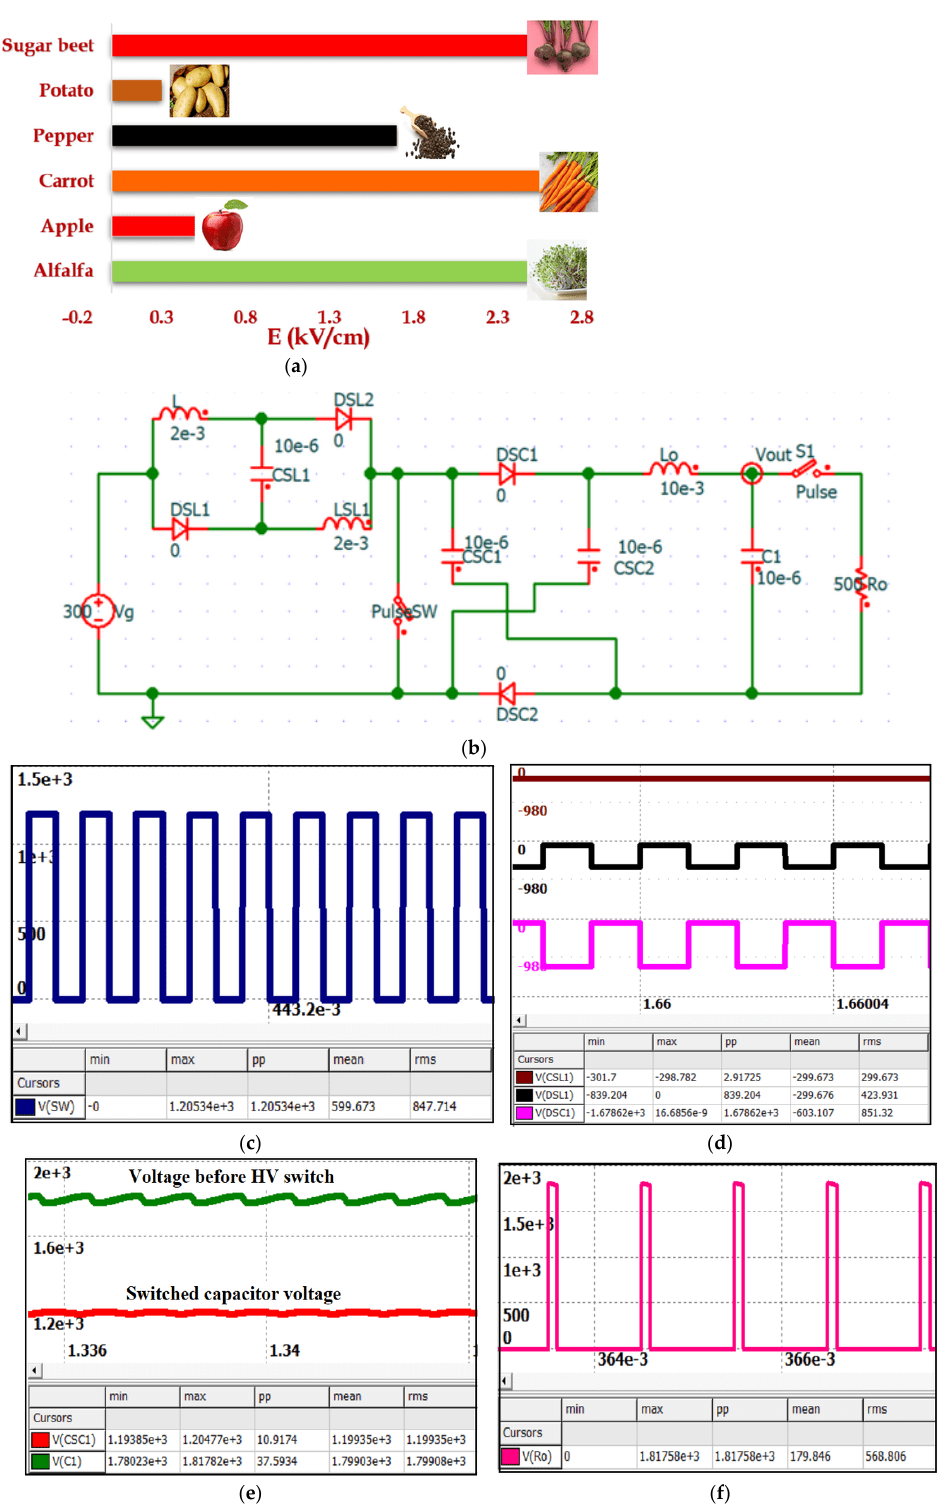
Figure 11. ( a ) Required electric field in kV/cm for food processing; ( b ) simulation circuit of PSLSC converter; ( c ) voltage across the switch; ( d ) voltage across the capacitor of the switched inductor cell (VSCL1), voltage across the diode of the switched inductor cell (VDSL1), voltage across the switched capacitor diode (VDSC1); ( e ) the voltage before the high voltage switch (SW) and voltage across the switched capacitor cell (VCSC1); ( f ) high voltage pulse across the load (RL).